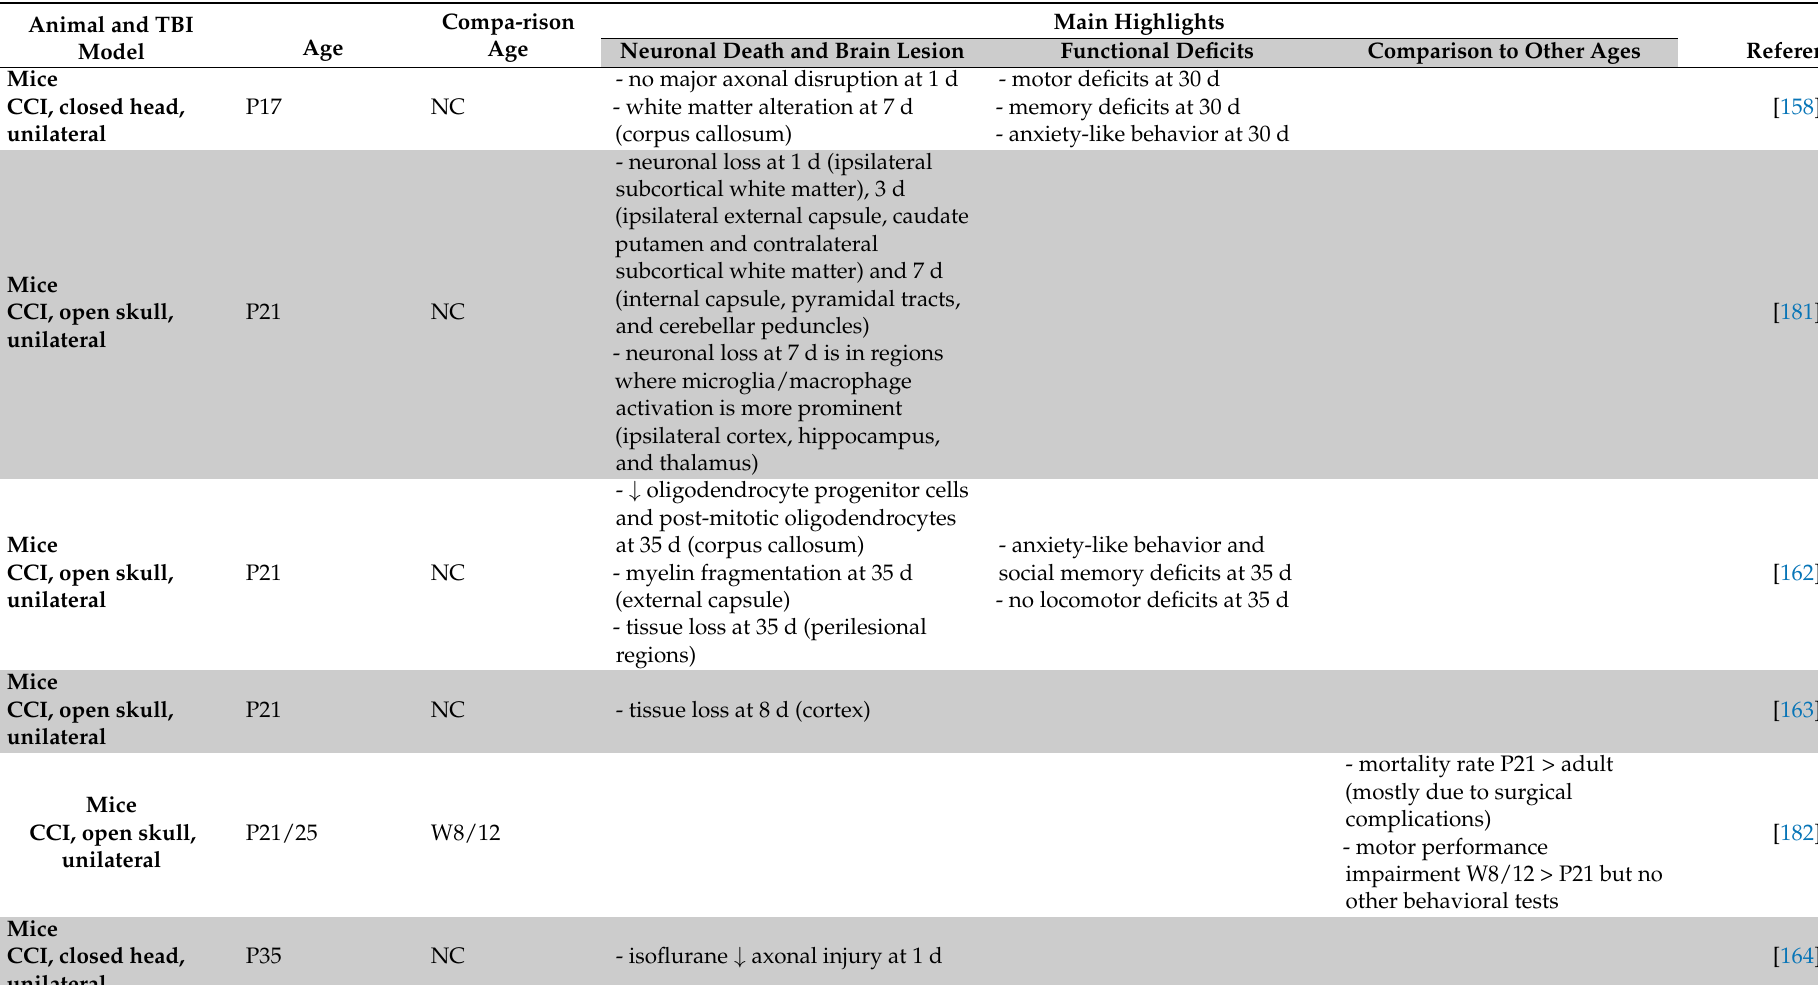
Table 3. Post-traumatic neuronal, tissue and functional consequences on juvenile and adolescent animals. Abbreviations: ↑ : increase; ↓ : decrease; CCI: controlled cortical impact; d: day post-injury; h: hour post-injury; IL: interleukin; m: month post-injury; LFP: lateral fluid percussion; MBP: Myelin Basic Protein; P: post-natal day; TBI: traumatic brain injury; W: post-natal weeks; WD: weight drop